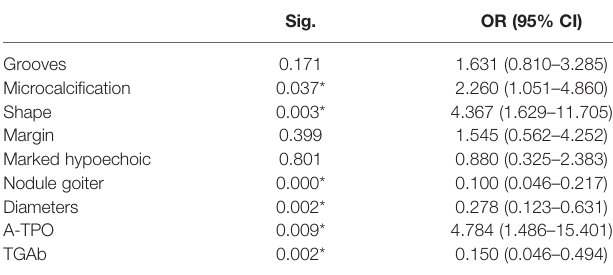
TABLE 1 | Clinicopathological characteristics and univariate analysis of thyroid nodules (n = 272).